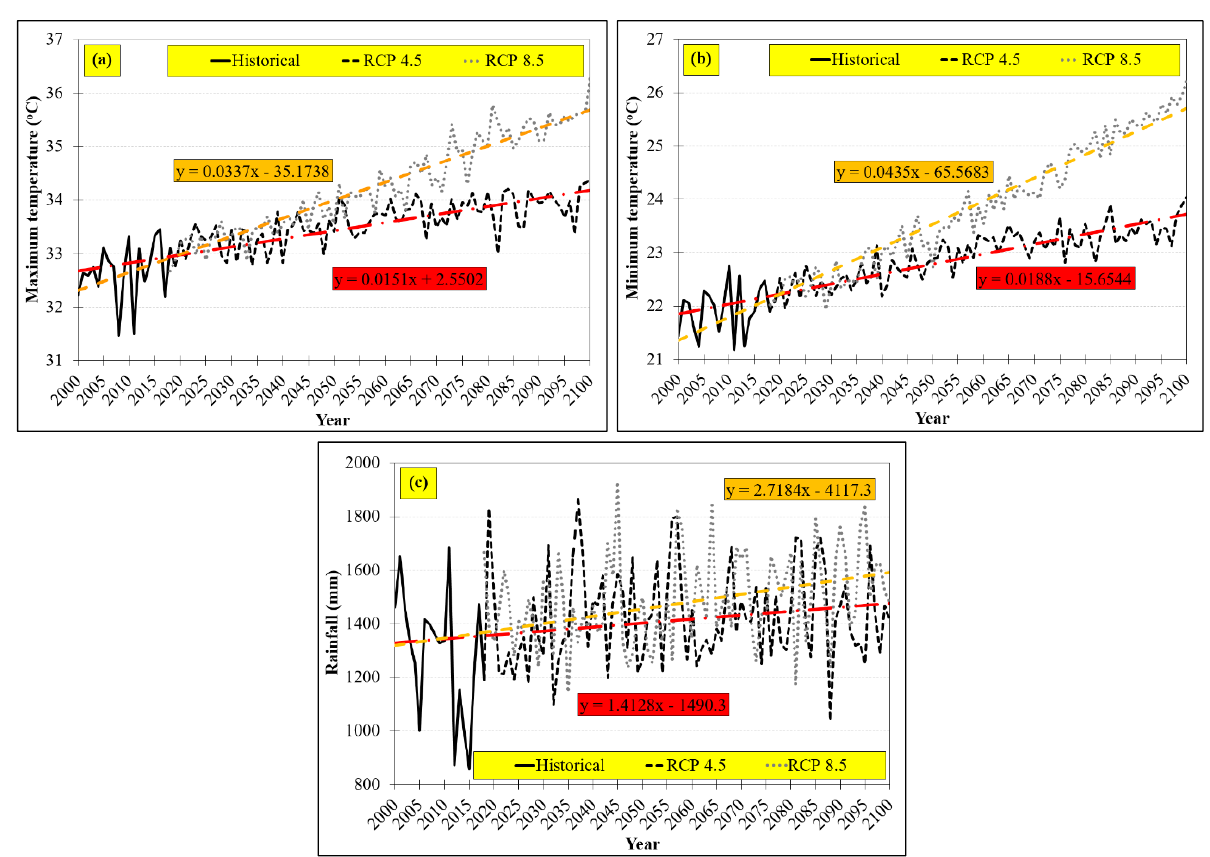
Figure 5. Average annual maximum and minimum temperatures ( a ) and ( b ), and average annual rainfall ( c ) under RCP 4.5 and 8.5 scenarios.